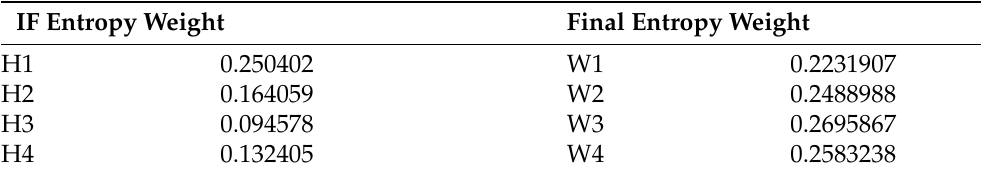
Table A6. IF entropy weights and final entropy weight for technological and system sub-barriers.